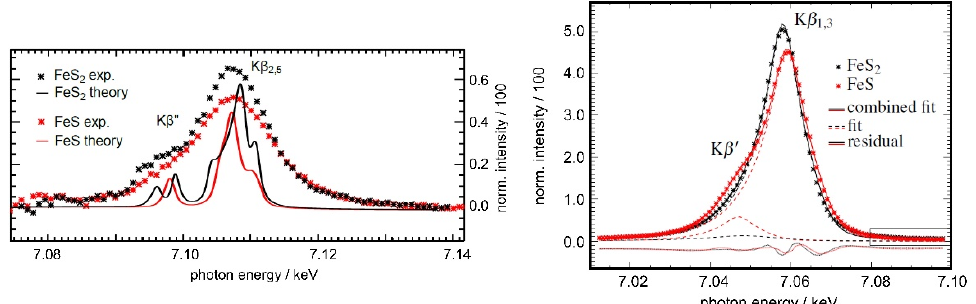
Figure 4. XES spectra of the iron sulfide compounds FeS and FeS 2 recorded by the full-cylinder von Hamos spectrometer. The measured and fitted data of the K β and valence-to-core X-ray emission lines are shown to the left and right, respectively. A spectral comparison between experimentally determined K β ” and K β 2,5 emission lines and related calculations using the OCEAN BSE code for core-level spectroscopy are depicted to the